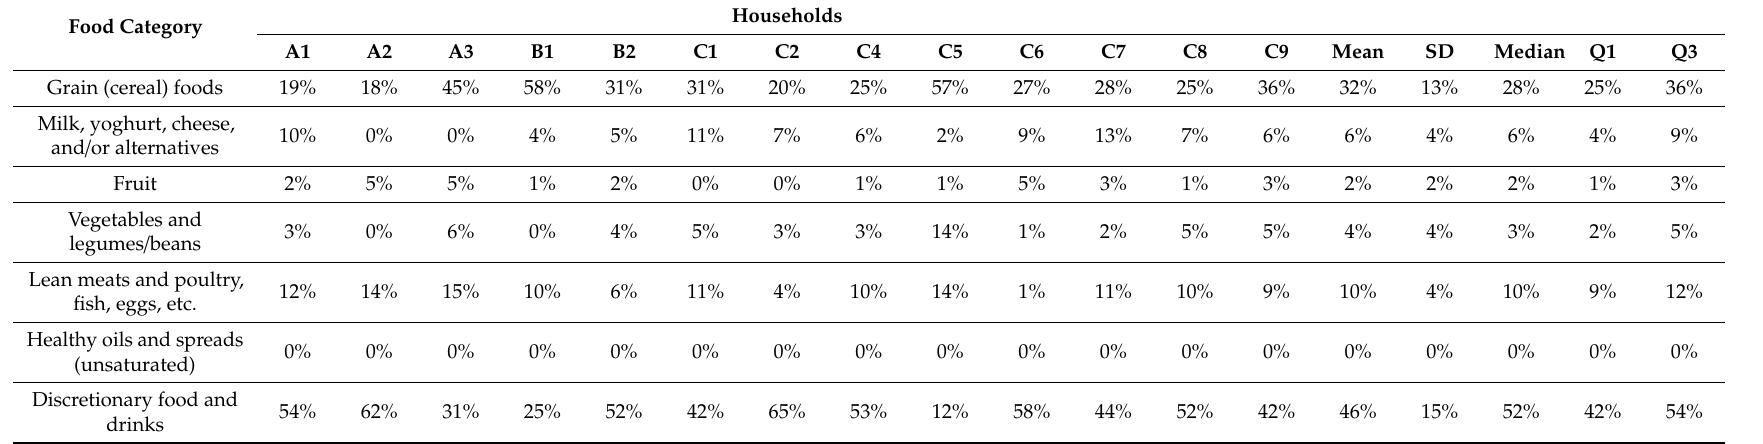
Table 3. Proportion (%) of total energy intake consumed, by Australian Dietary Guidelines food group category, per